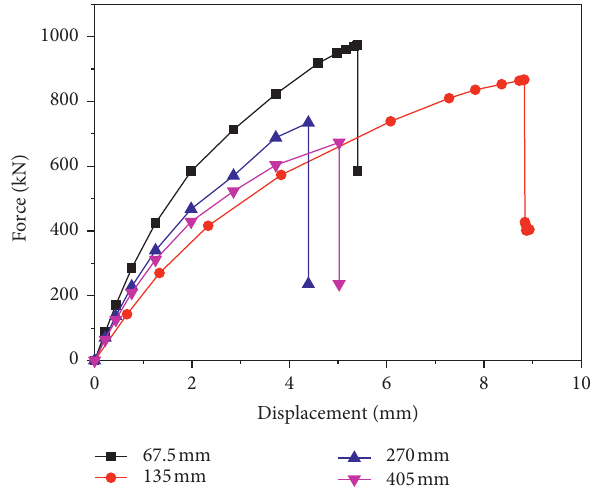
Figure 31: Load-displacement curves of members with different stud spacing.